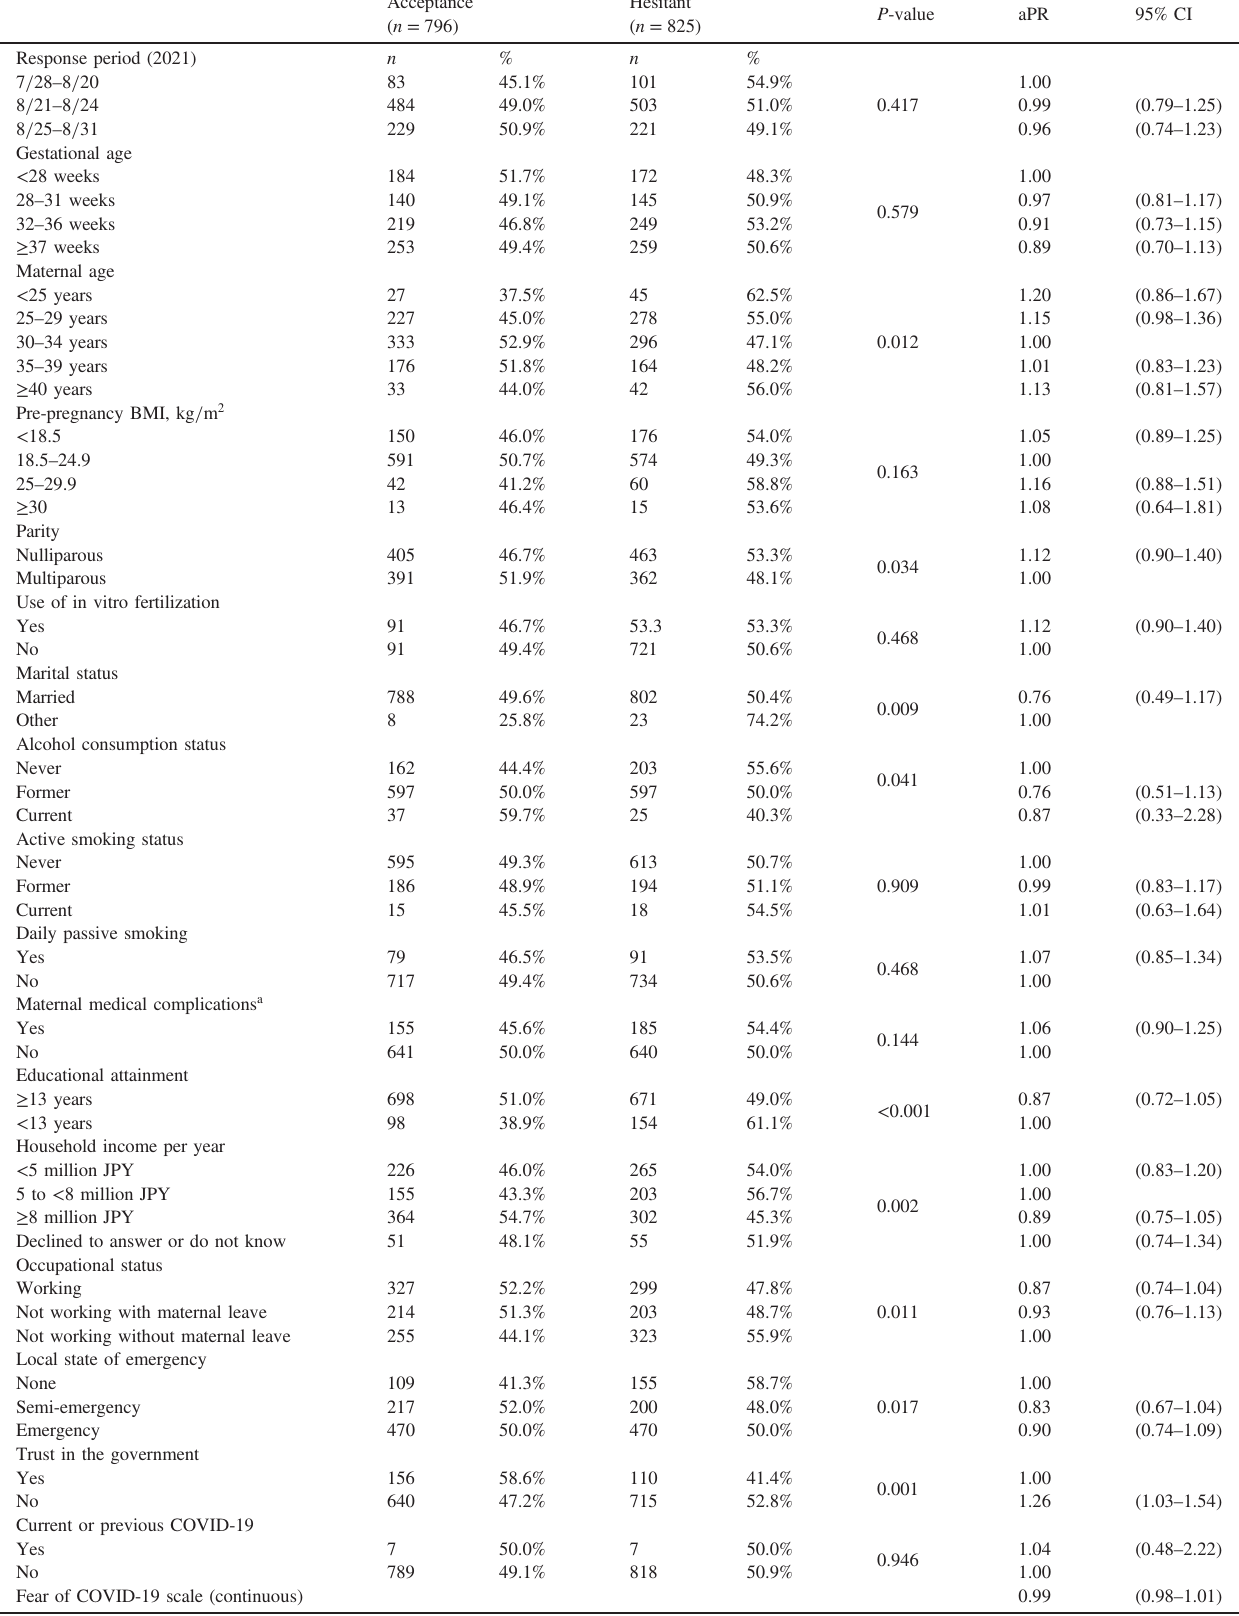
Table 2. Factors associated with vaccine hesitancy among all pregnant women in this